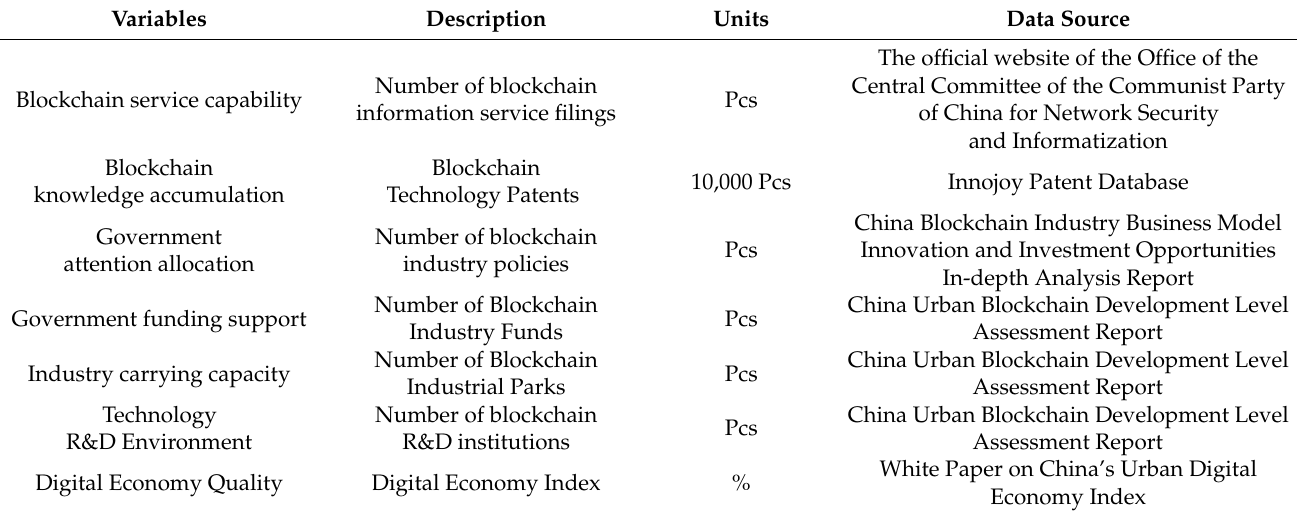
Table 2. Variable description and data